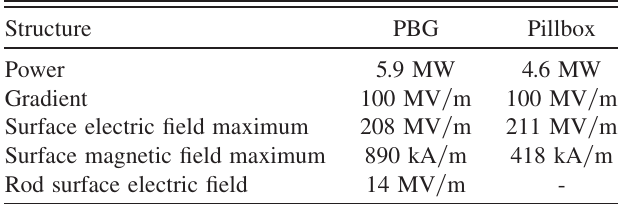
TABLE III. HFSS simulation field calibration numbers for PBG structure.